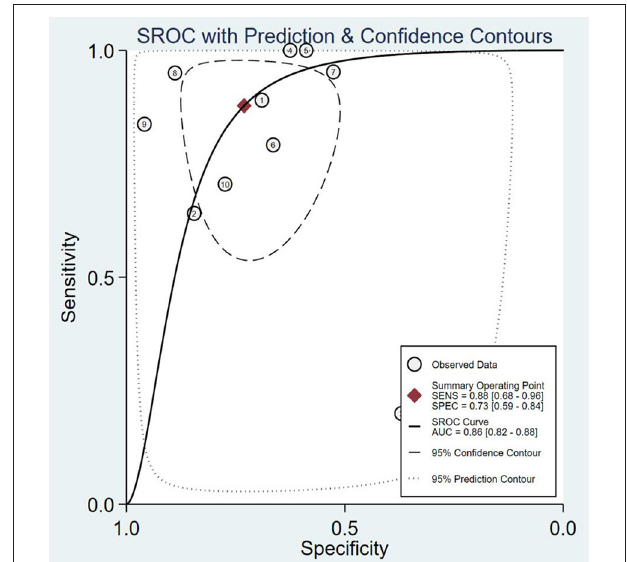
FIGURE 3 | SROC curves of 18F-fluciclovine in PET/CT for diagnosis of prostate cancer. SENS, sensitivity; SPEC, specificity; AUC, area under the